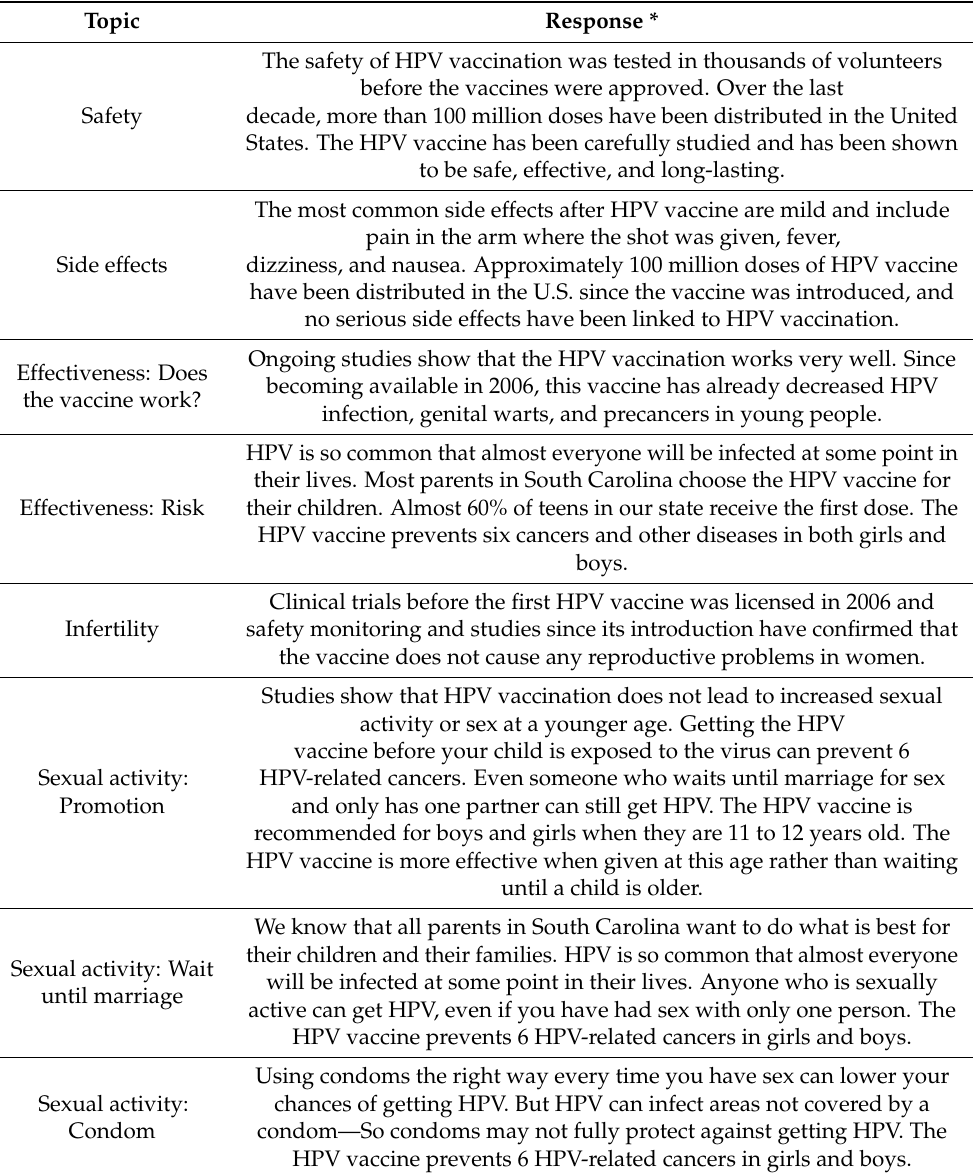
Table 5. Standard responses to misinformation